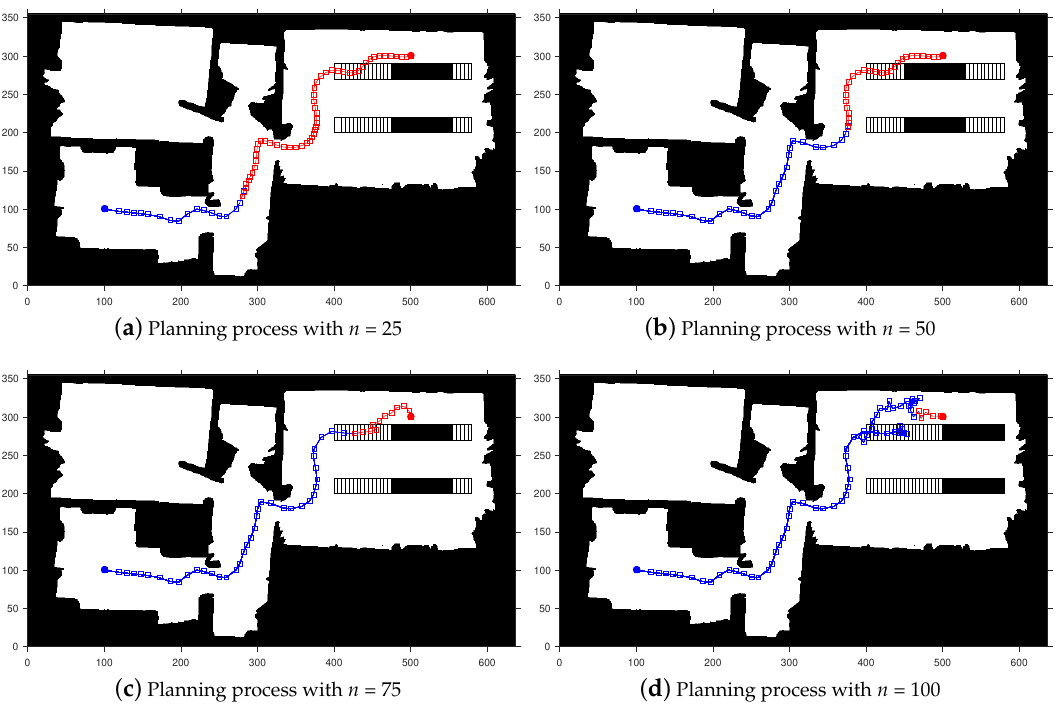
Figure 6. The process of exploring a path on the map with horizontally dynamic